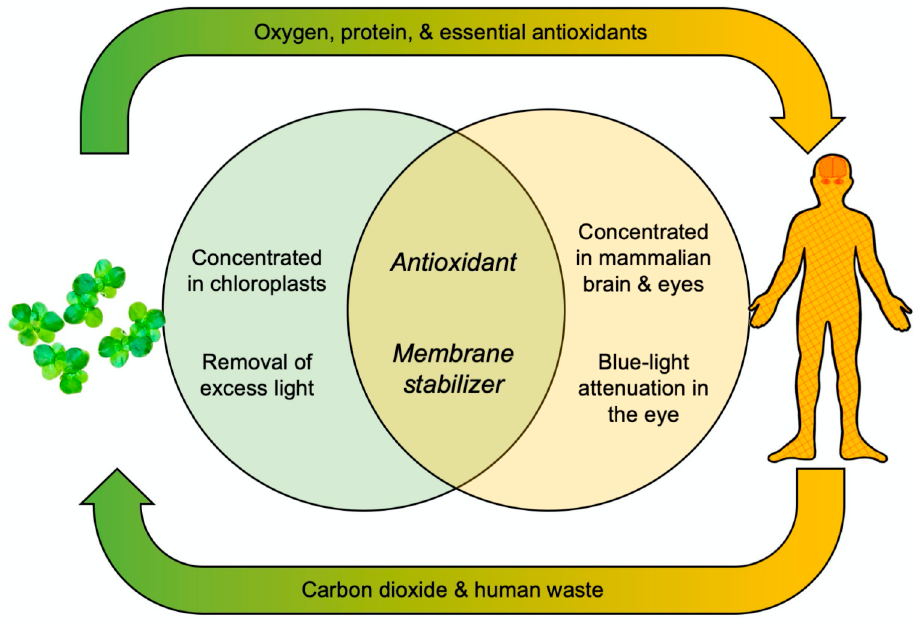
Figure 2. Schematic depiction of the functions of zeaxanthin in plants and humans with both over- lapping and analogous aspects.